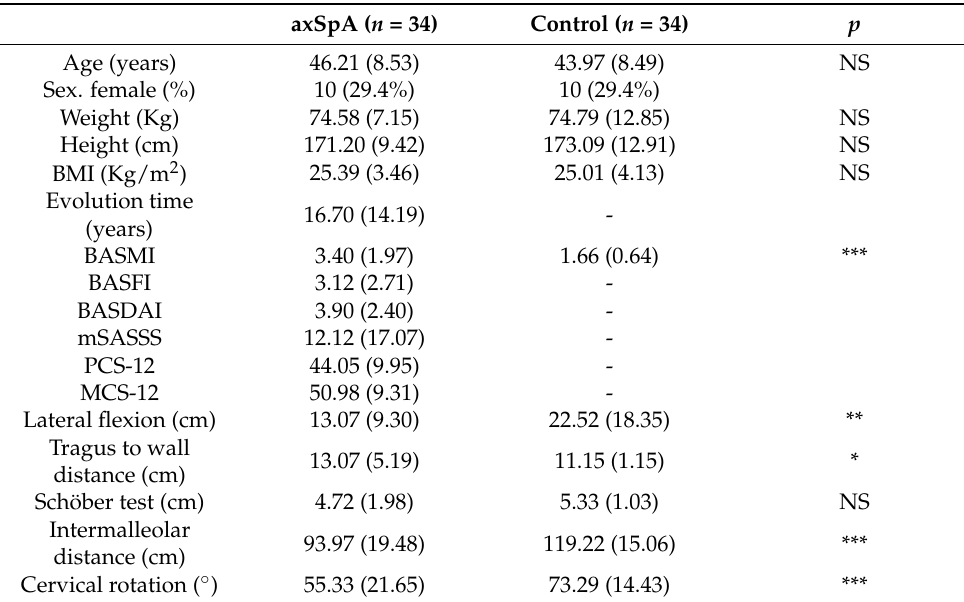
Table 1. Demographic characteristics of the